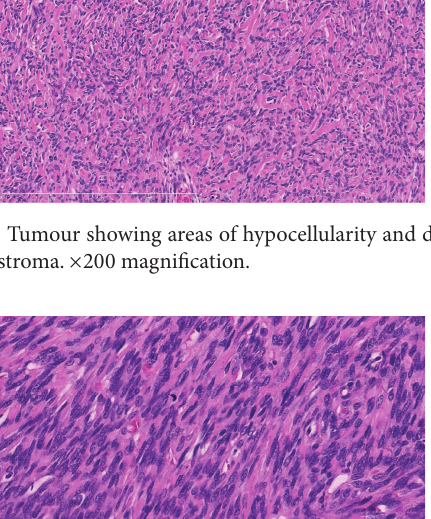
Figure 2: Large homogenous solid mass completely resected (mac- roscopic view).